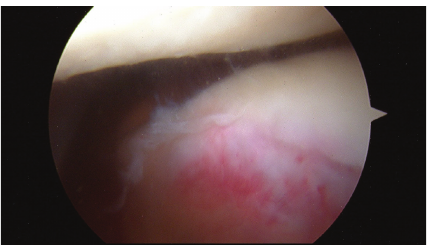
Figure 6: Image from arthroscopy showing fibrillation of the lateral trochlear